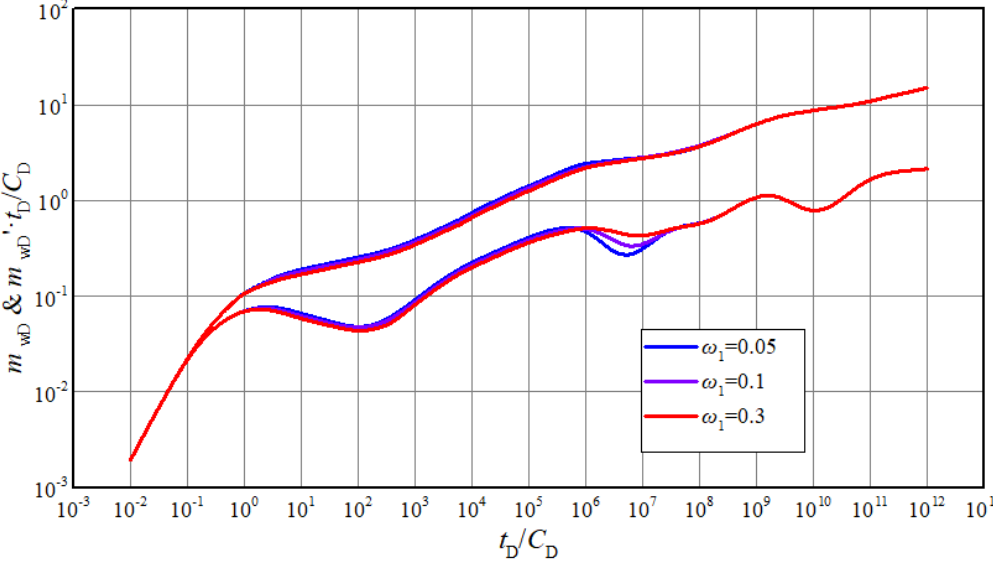
Figure 9. The effect of storability ratio of inner region on typical curves.